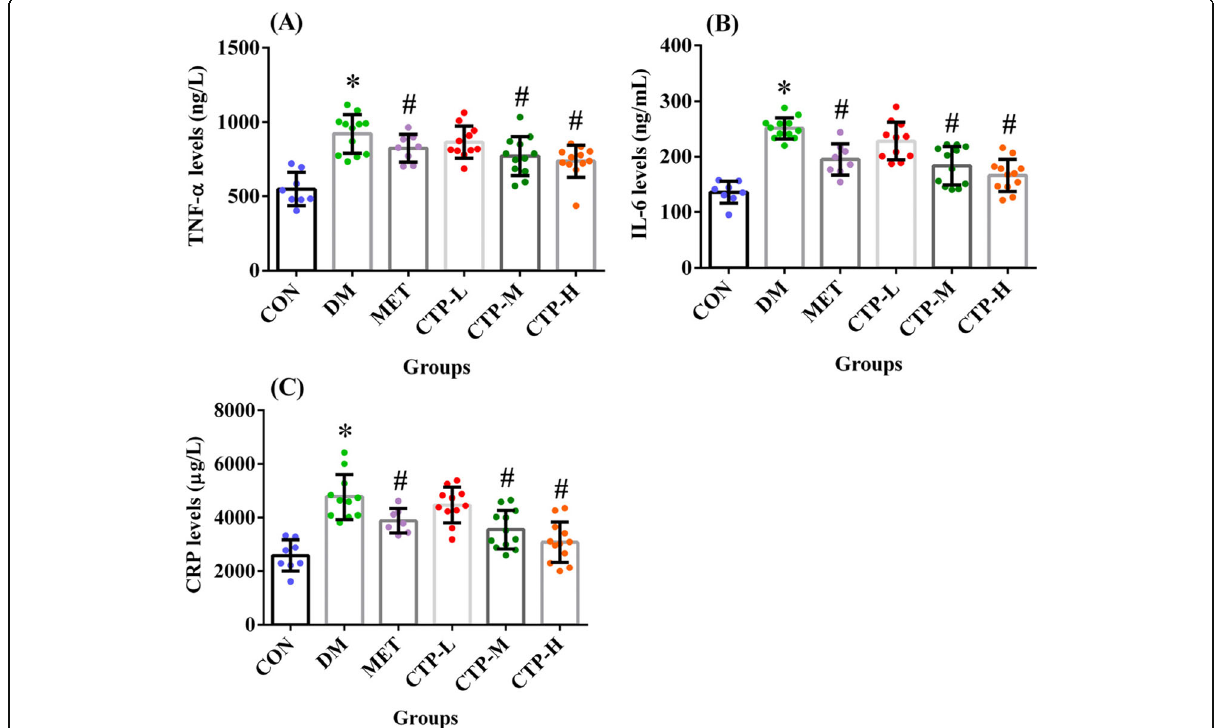
Fig. 6 Effects of CTP on the serum inflammatory cytokine levels in diabetic mice. The following values were measured 28 days after CTP was administered ( a ) TNF- α levels. b IL-6 levels. c CRP levels. Data are presented as the mean ± SD ( n = 8 – 12). * p < 0.05 as compared with CON. # p < 0.05 as compared with